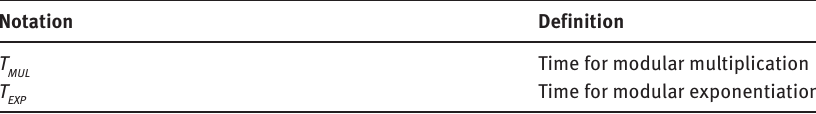
Table 1. Definitions of notations.